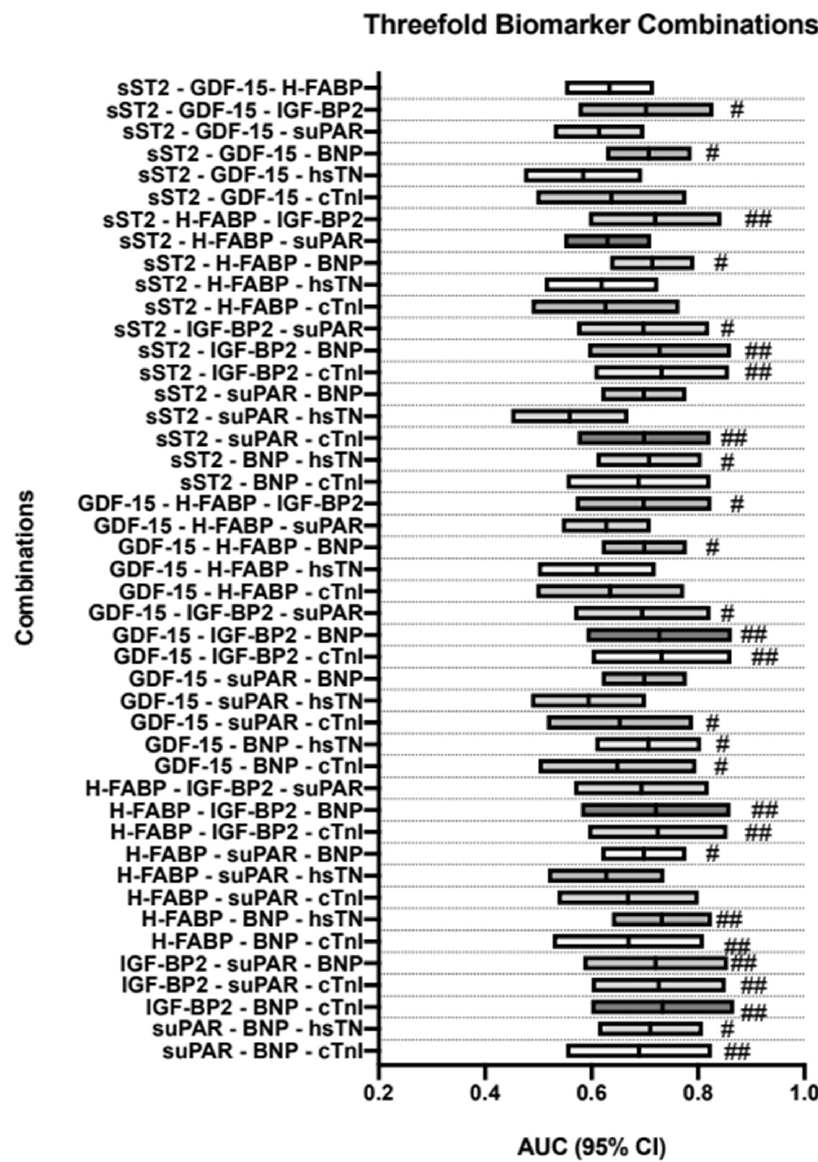
Figure 6. Three-way biomarker combinations with corresponding AUROC analyses and diagnostic strength; # YI ≥ 35; ## YI ≥ 40. BNP: brain natriuretic peptide; cTnI: cardiac troponin I; hsTN: high- sensitive troponin; sST2: soluble suppression of tumorigenesis-2; GDF-15: growth/differentiation factor-15; H-FABP: heart-type fatty acid-binding protein; IGF-BP2: insulin-like growth factor binding protein 2; suPAR: soluble urokinase-type plasminogen activator receptor; YI: Youden Index. Combinations of particular note were GDF15 + IGF-BP2 + cTnI (AUROC = 0.732, 95%CI = 0.600–0.863, p = 0.002, sensitivity = 0.58, specificity = 0.90, YI = 48), H-FABP + IGF-BP + cTnI (AUROC = 0.724, 95%CI = 0.593–0.855, p = 0.002, sensitivity =